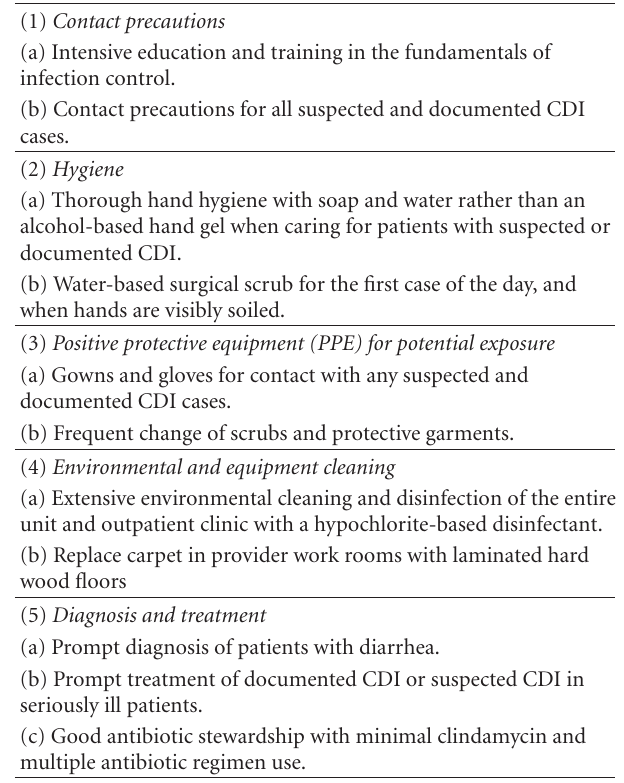
Table 3: Infection control measures used for an obstetrical service outbreak of Clostridium di ffi cile Infection